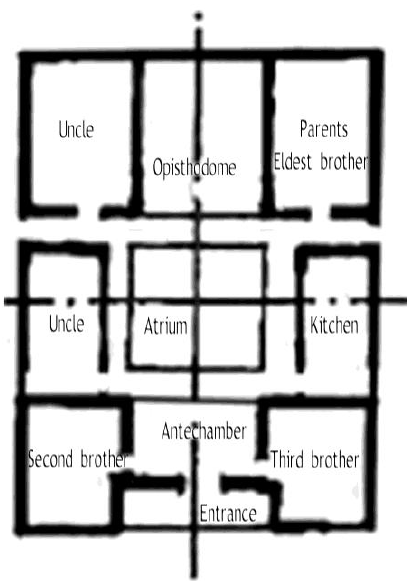
Figure 6. Housing